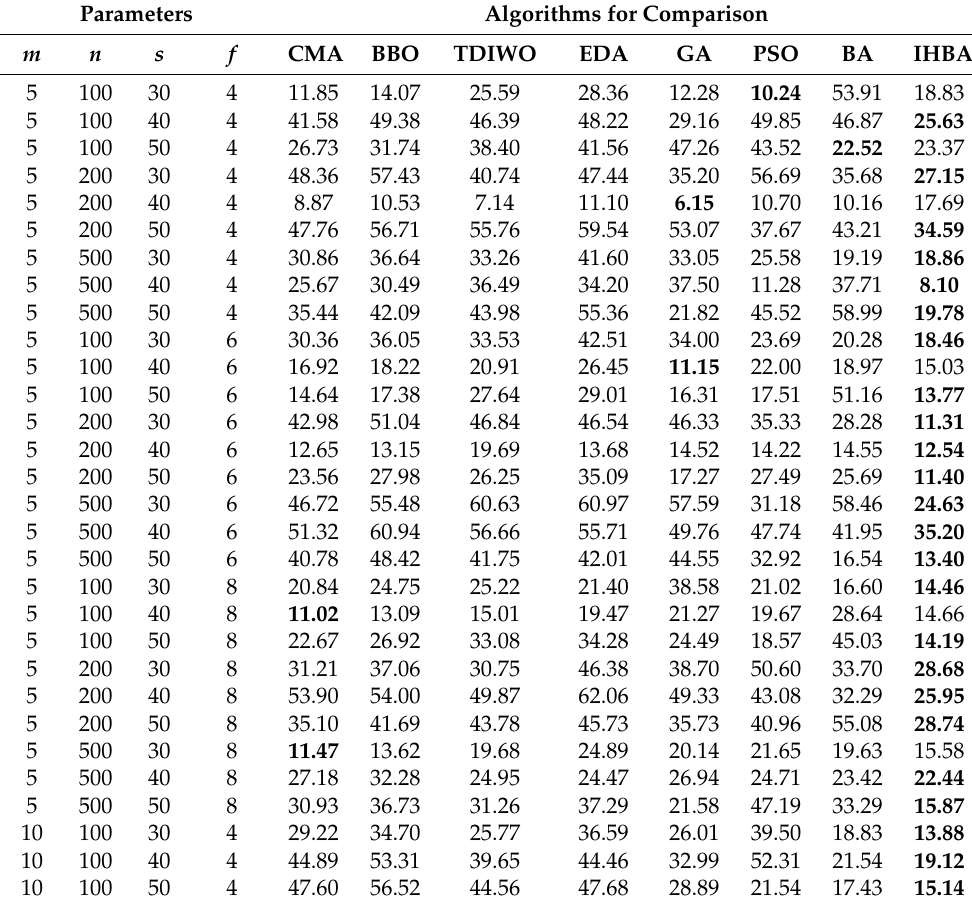
Table 4. The Average RPD Values at C = 20. It can be seen from the bold figures that the value of PRD of the proposed algorithm IHBA in this paper is smaller than that of other algorithms in the vast majority of combinatorial solutions, including the recognized TDIWO algorithm and the original bat